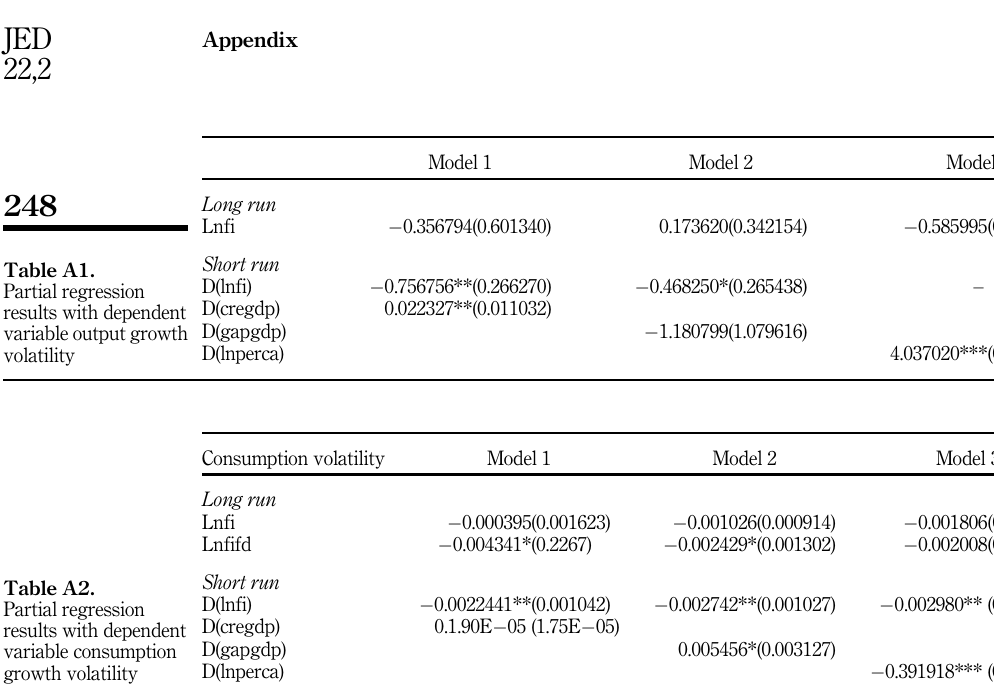
results with dependent variable consumption growth